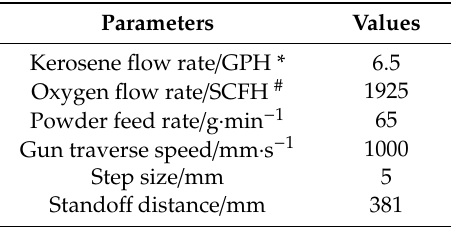
Table 2. High-velocity oxygen fuel parameters.